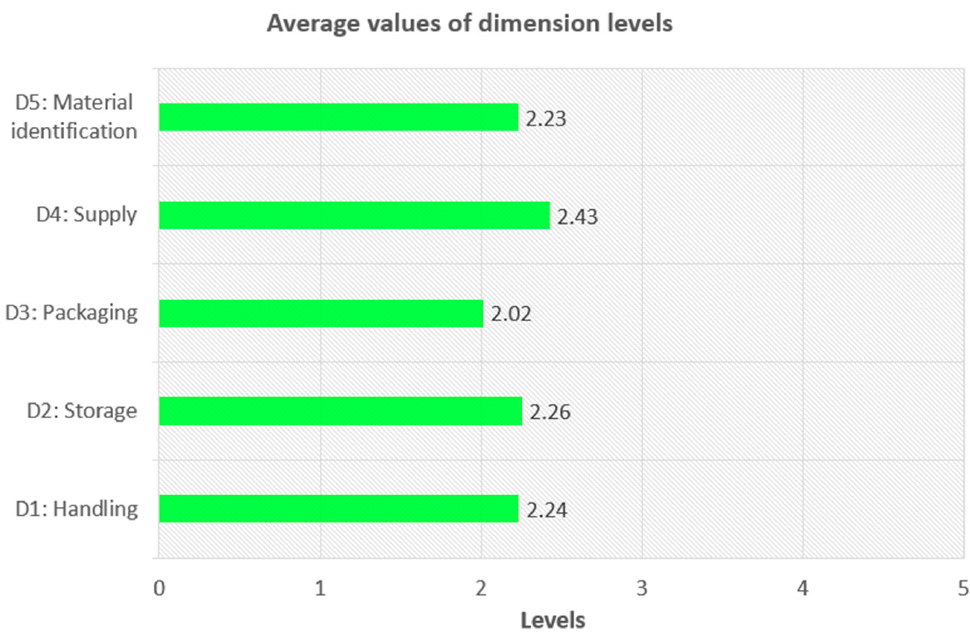
Figure 2. Average values of dimension levels of all companies .